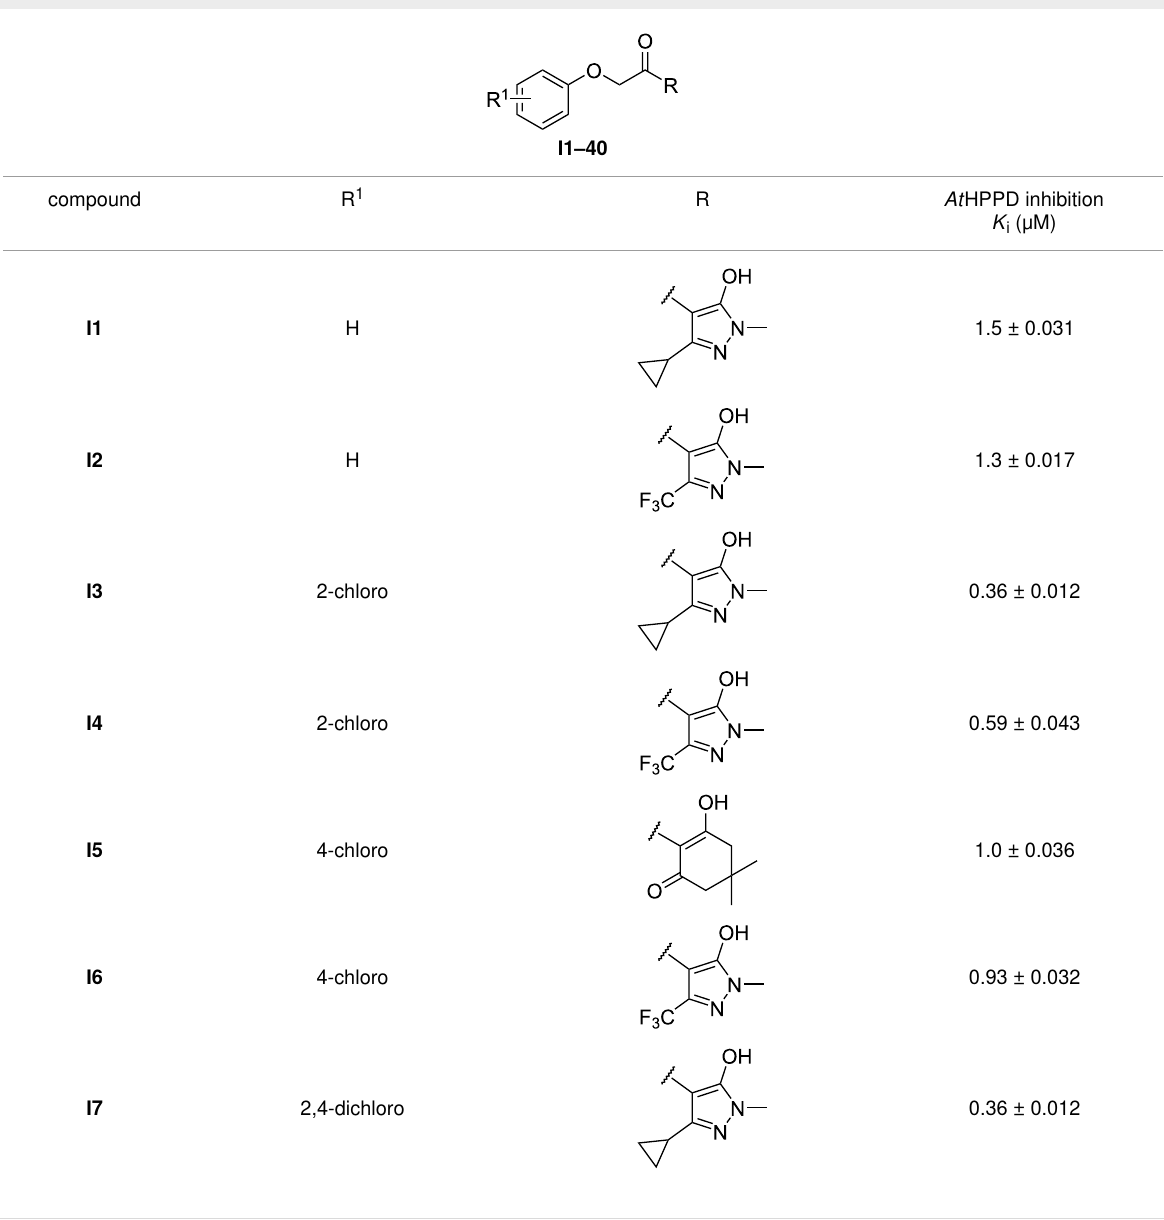
Table 1: Chemical structures of title compound I and their biological activity against At